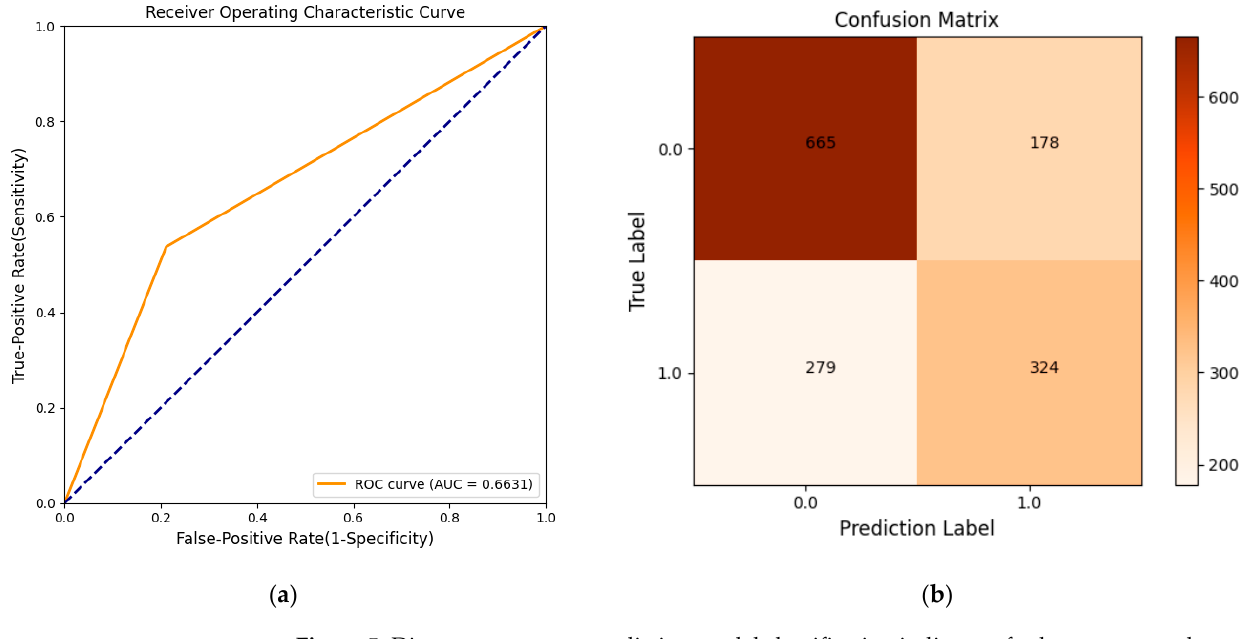
Figure 5. Disease occurrence prediction model classification indicators for hot pepper anthracnose. ( a ) ROC curve; and ( b ) confusion matrix.